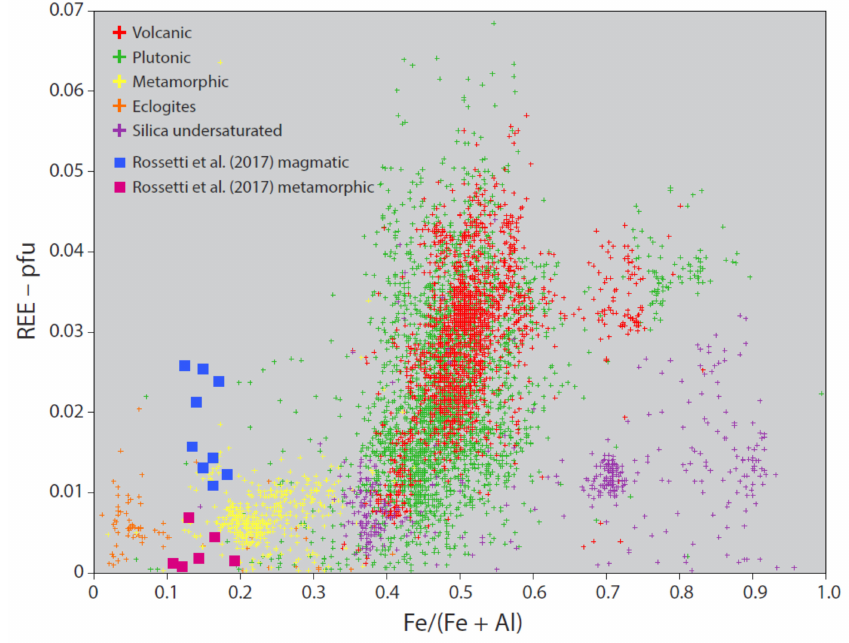
Figure 17. REE’s plotted versus normalized Fe in titanite. Data from different genetic groups are shown along with data from granodiorite of the Menderes Massif, western Turkey [117].